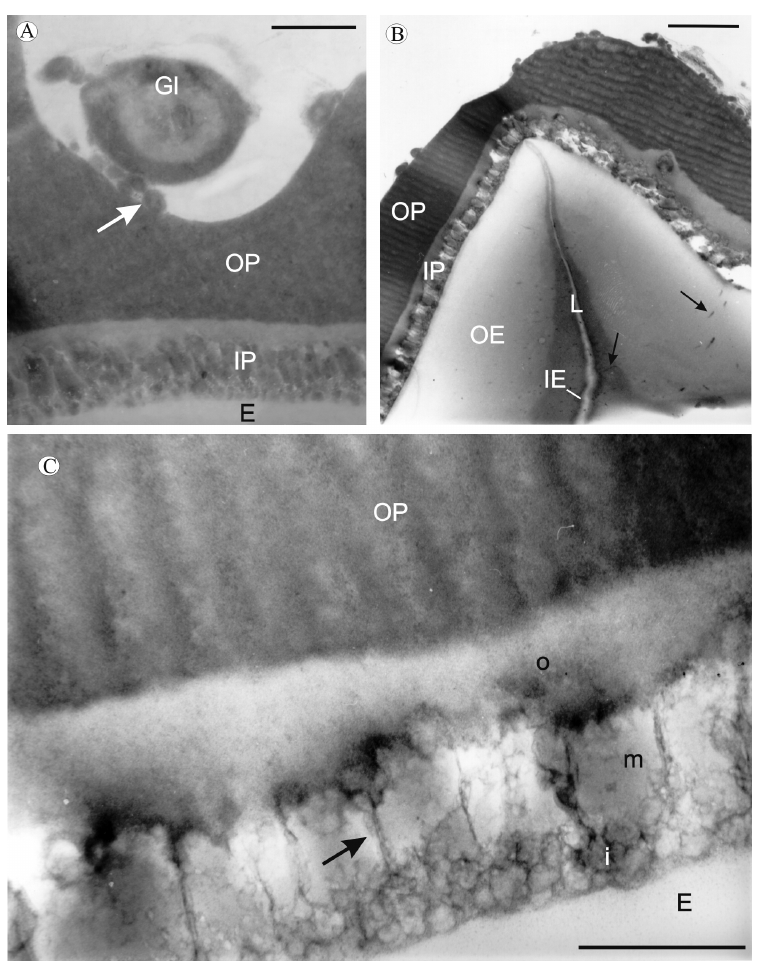
Fig. 2 – Spore wall sections of Sphaeropteris gardneri as seen with TEM. A. This figure shows globules (Gl) of different sizes, some of them are fused (arrow) to the perispore surface (OP). IP: inner perispore, E: exospore. Scale bar: 250 nm. B. Section throughout the laesura (L). Two layers of the exospore are visible; the inner exospore (IE) is more contrasted than the outer exospore (OE). The channels associated to the laesura have a dark content (arrows). The inner perispore (IP) is three stratified. The outer perispore (OP) is one stratified and homogeneous. Scale bar: 1 μ m. C. Section through the perispore. The inner perispore has three strata: the inner stratum (i) is composed of a three-dimensional network of threads and shows an irregular margin. The middle stratum (m) is composed of threads mainly radially oriented (arrow). The outer stratum (o) is composed of a network of fine highly contrasted fibres immersed in a less contrasted matrix. Within the outer perispore layer (OP), tiny threads are evident. E: exospore. Scale bar: 250